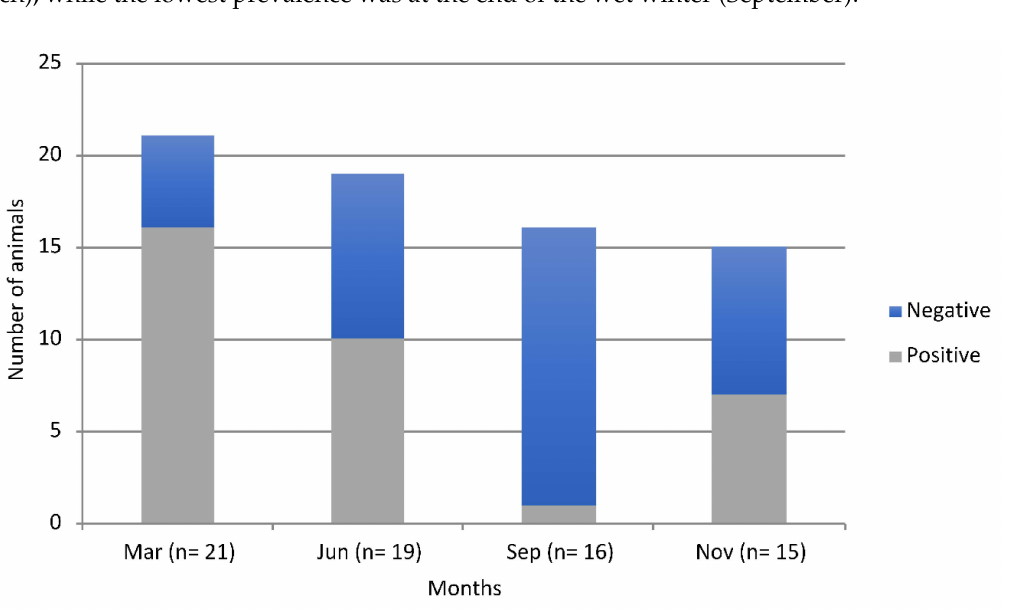
Figure 2. Monthly proportion of Salmonella spp. positive and negative animals on Rottnest Island between March and December of